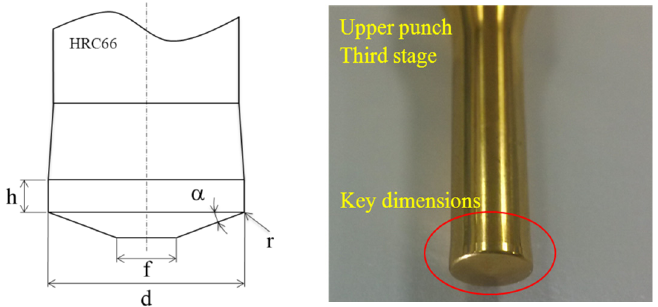
Figure 7. Key dimensions of the third stage upper punch for optimization design.